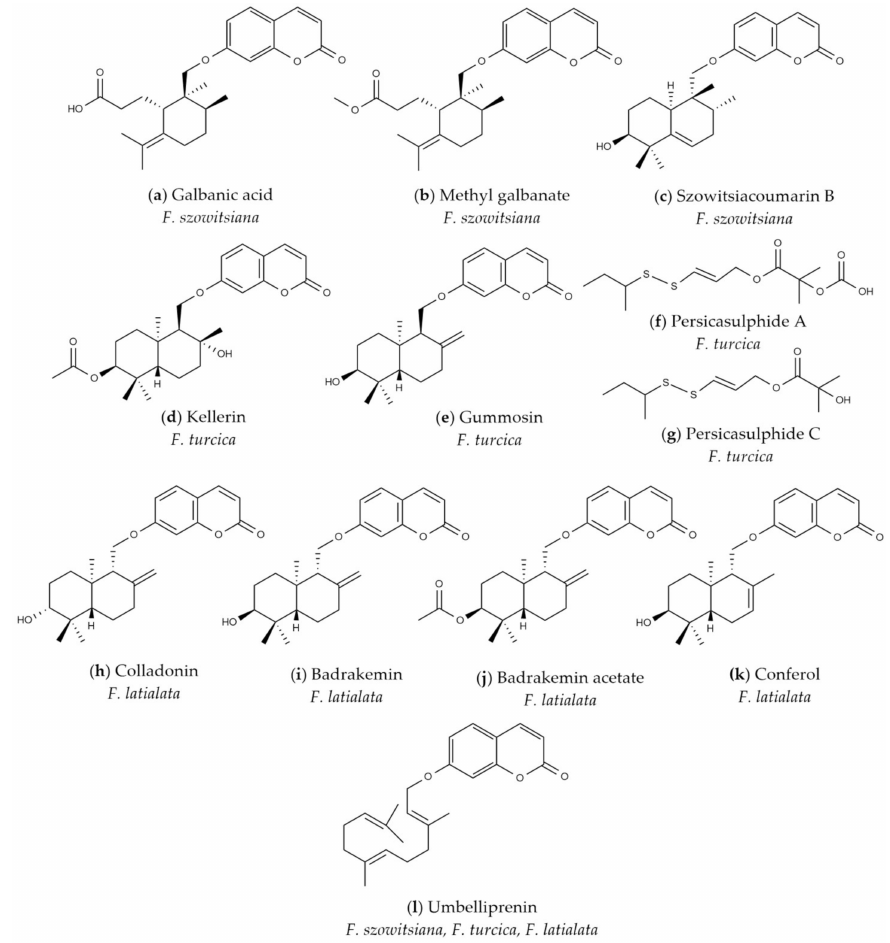
Figure 8. Secondary metabolites of Ferula latialata , F. turcica , and F. szowitsiana